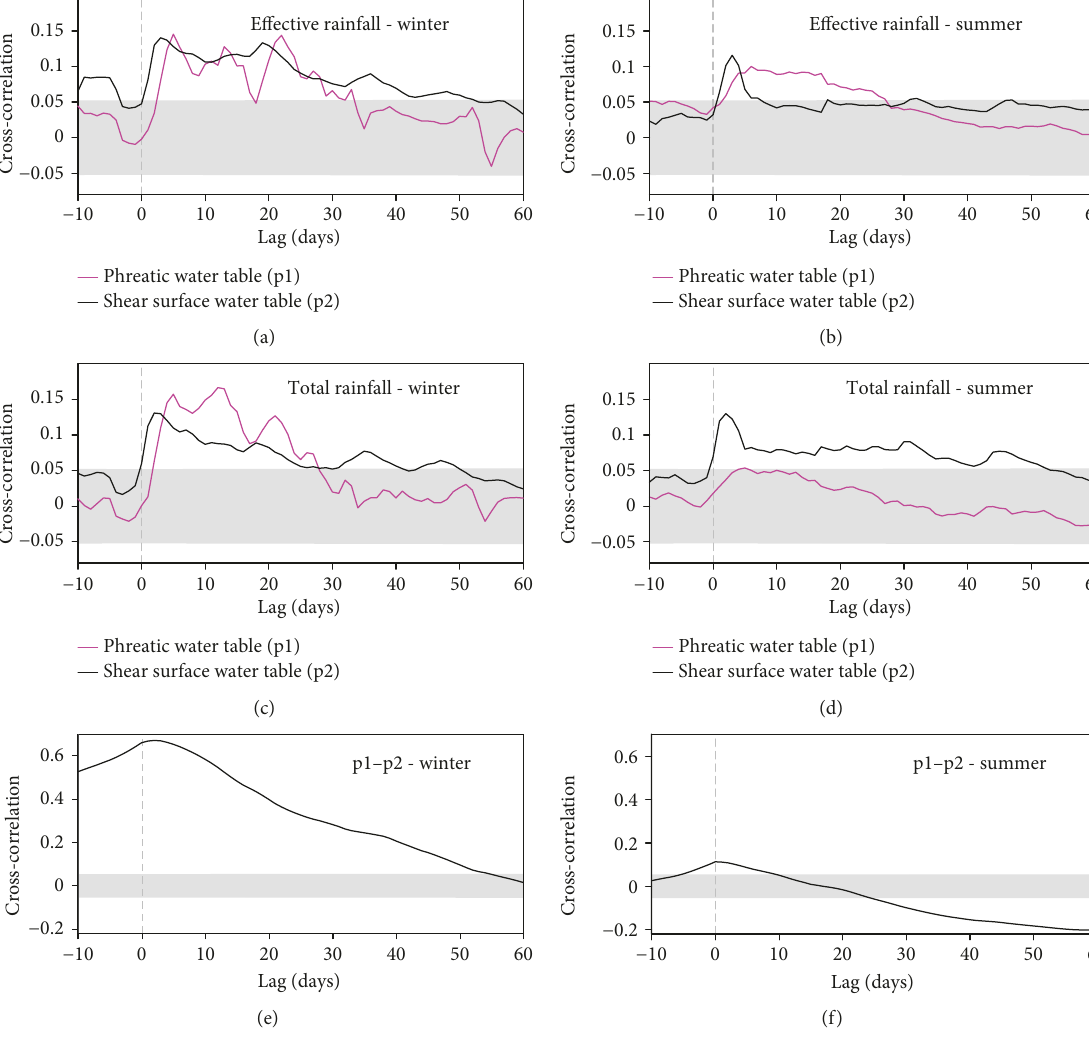
Figure 10: Seasonal cross-correlation of water table and rainfall. (a) and (b) Cross-correlation of water tables and e ff ective rainfall in winter and summer, respectively. (c) and (d) Cross-correlation of water tables and total rainfall in winter and summer, respectively. (e) and (f) Cross- correlation of water table levels in winter and summer,